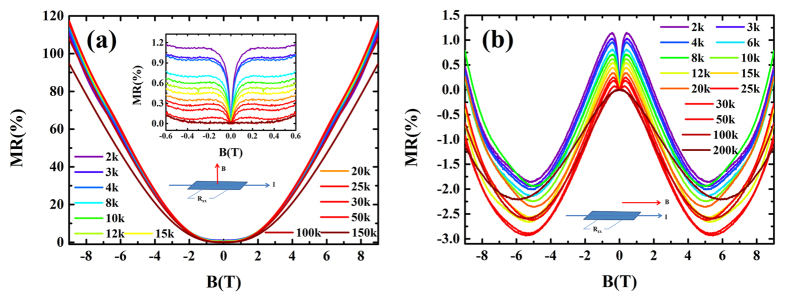
The MR with the applied magnetic field B⊥E or B||E.Schematic diagram of electrical transport measurements are shown in insert respectively. (a) The magnetoresistance vs magnetic field in B⊥E at various temperatures from 2 K to 150 K. The insert show the sharp cusp at low magnetic field. (b) The magnetoresistance with B‖E at various temperatures from 2 K to 200 K. The WAL effect is also clear around zero fields. With the magnetic field increasing, the MR decreasing shows a negative MR phenomenon with a weak temperature dependent below 150 K. However, it increase with increasing magnetic field when B > 5T.